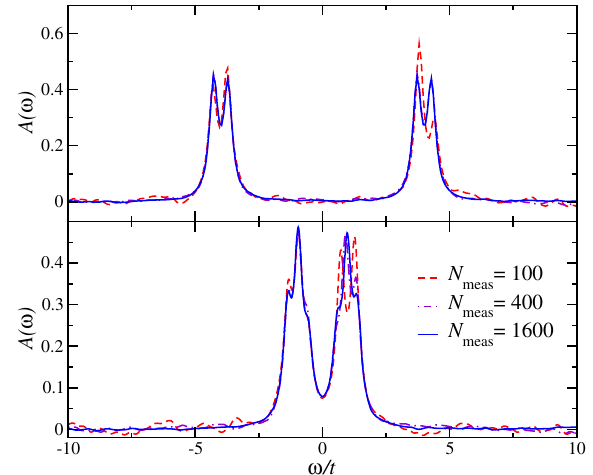
FIG. 2. Spectral function of a Hubbard model on the Bethe lattice (with hopping t ij ¼ t=